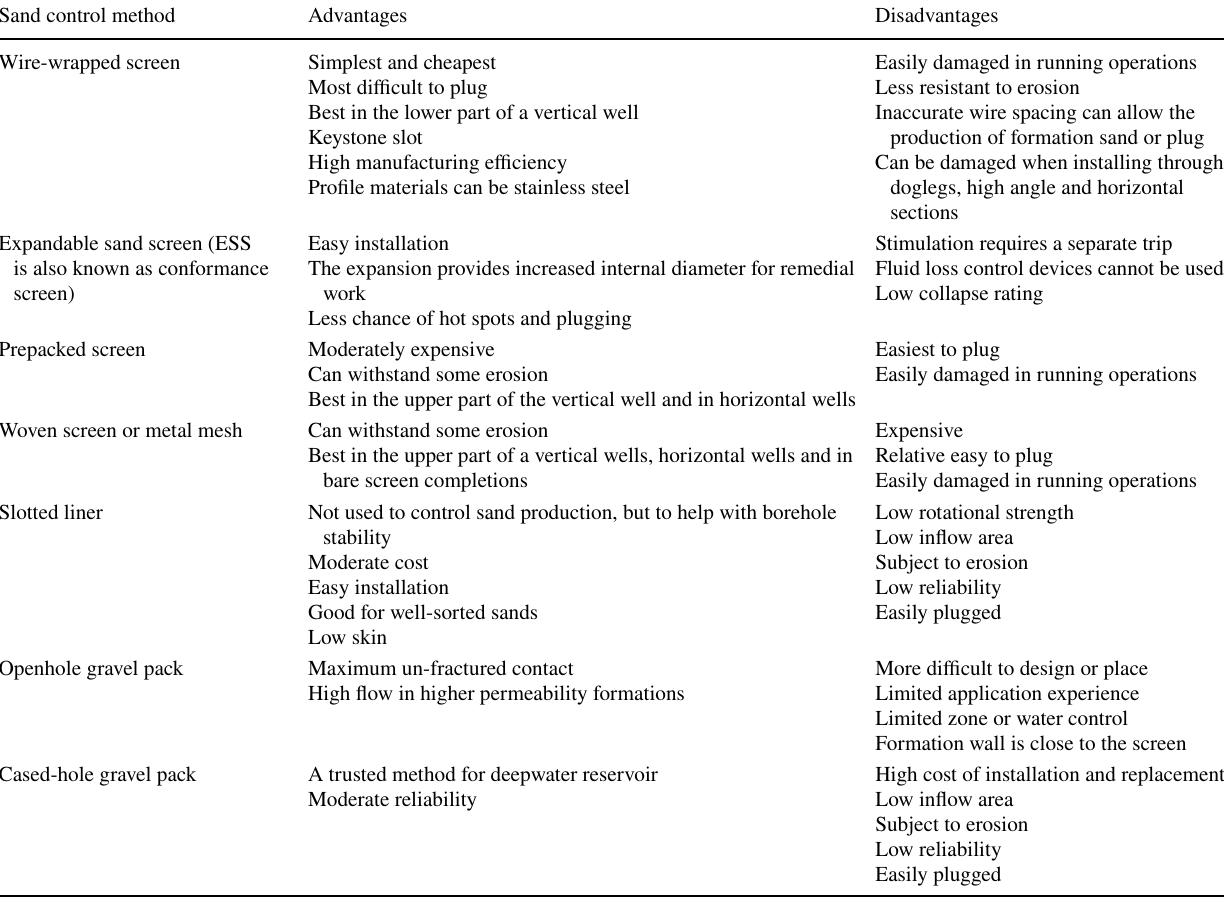
Table 2 Advantages and disadvantages of conventional sand control methods (King 2013; Parlar et al.